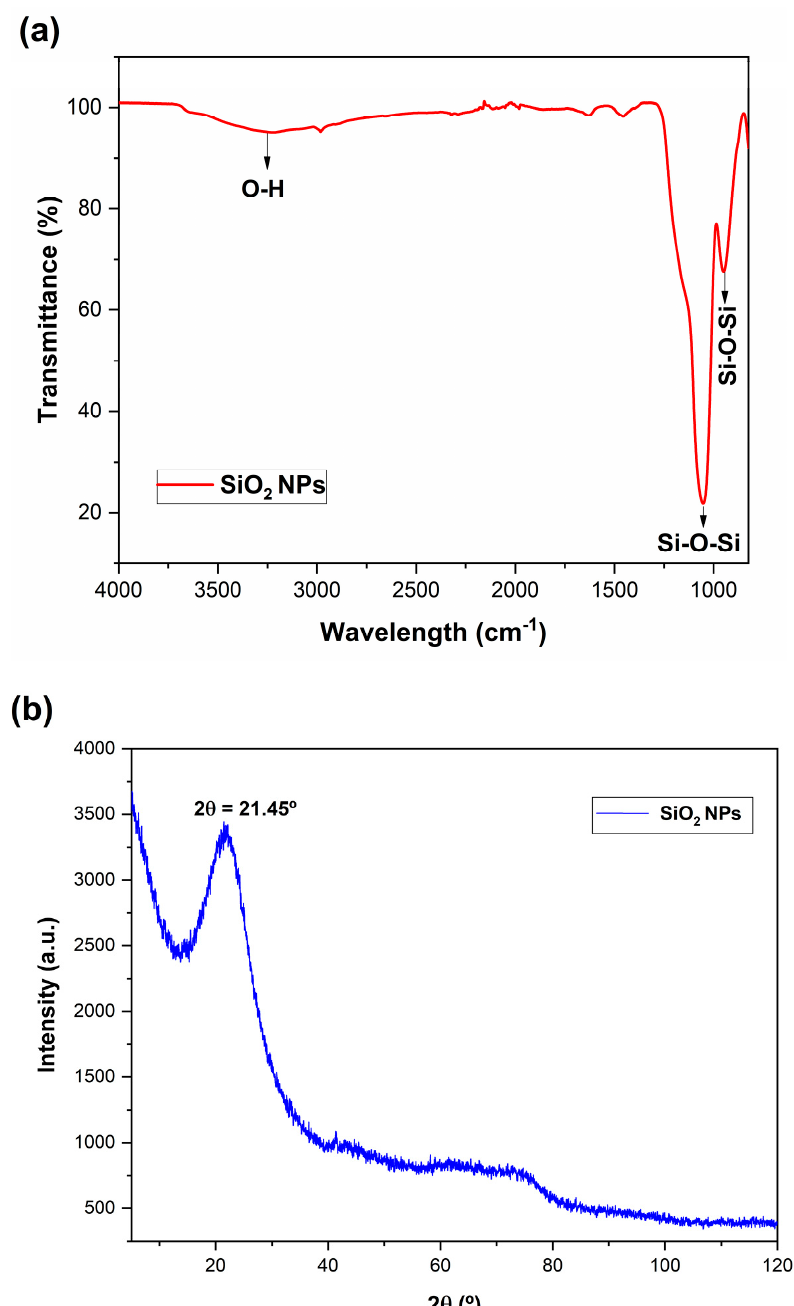
Figure 1. FTIR spectrum of SiO 2 @CisPt NPs ( a ). XRD pattern of SiO 2 NPs synthesized by the sol–gel method ( b ).